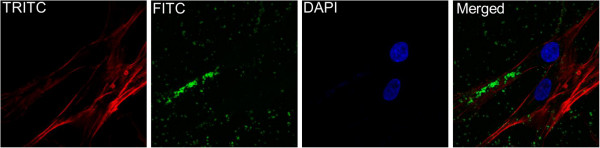
P. gingivalis adheres to and invades dermal fibroblasts. Dermal fibroblasts were seeded on a coverslip and incubated for 24 h. The cells were then stimulated with FITC-labeled P. gingivalis (MOI:100) for 6 h. F-actin was visualized by incubating the cells with Alexa Fluor® 594 phalloidin (TRITC) and the nuclei were visualized by counterstaining the cells with DAPI. Magnification is 60× (Olympus FluoviewTM FV1000, Germany).